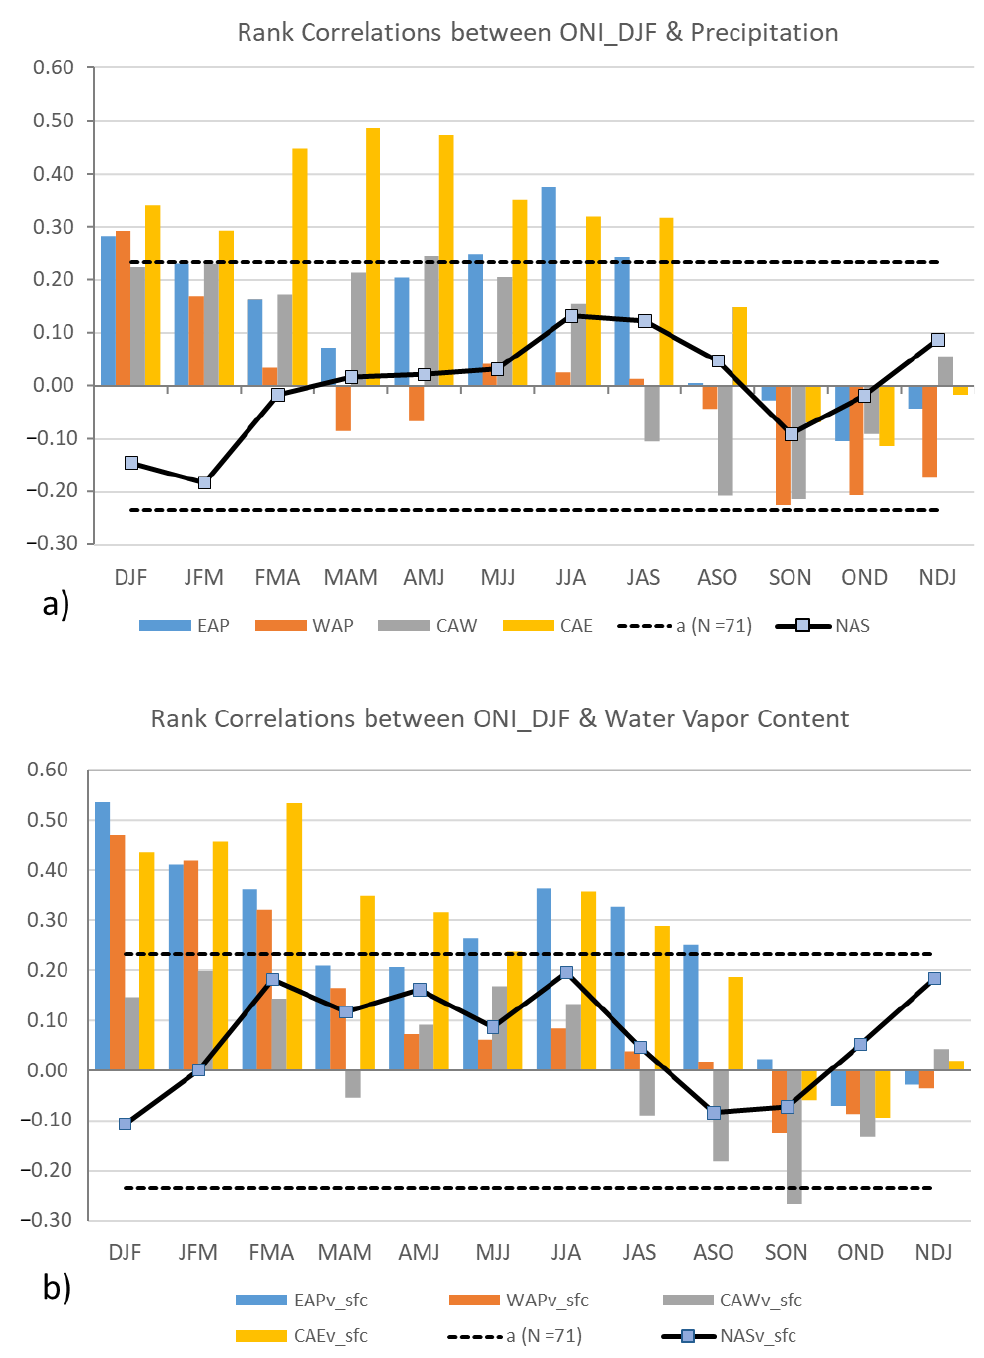
Figure 7. Spearman’s rank correlation between January (DJF) ONI and ERA5 3-month mean precipita- tion in the subregions during 1950–2021 ( a ), and ERA5 surface water vapor content (unit: kg m − 2 ) ( b ). Additionally displayed are the critical values corresponding to the 0.05 significance level ( rho = 0.2484 for N =